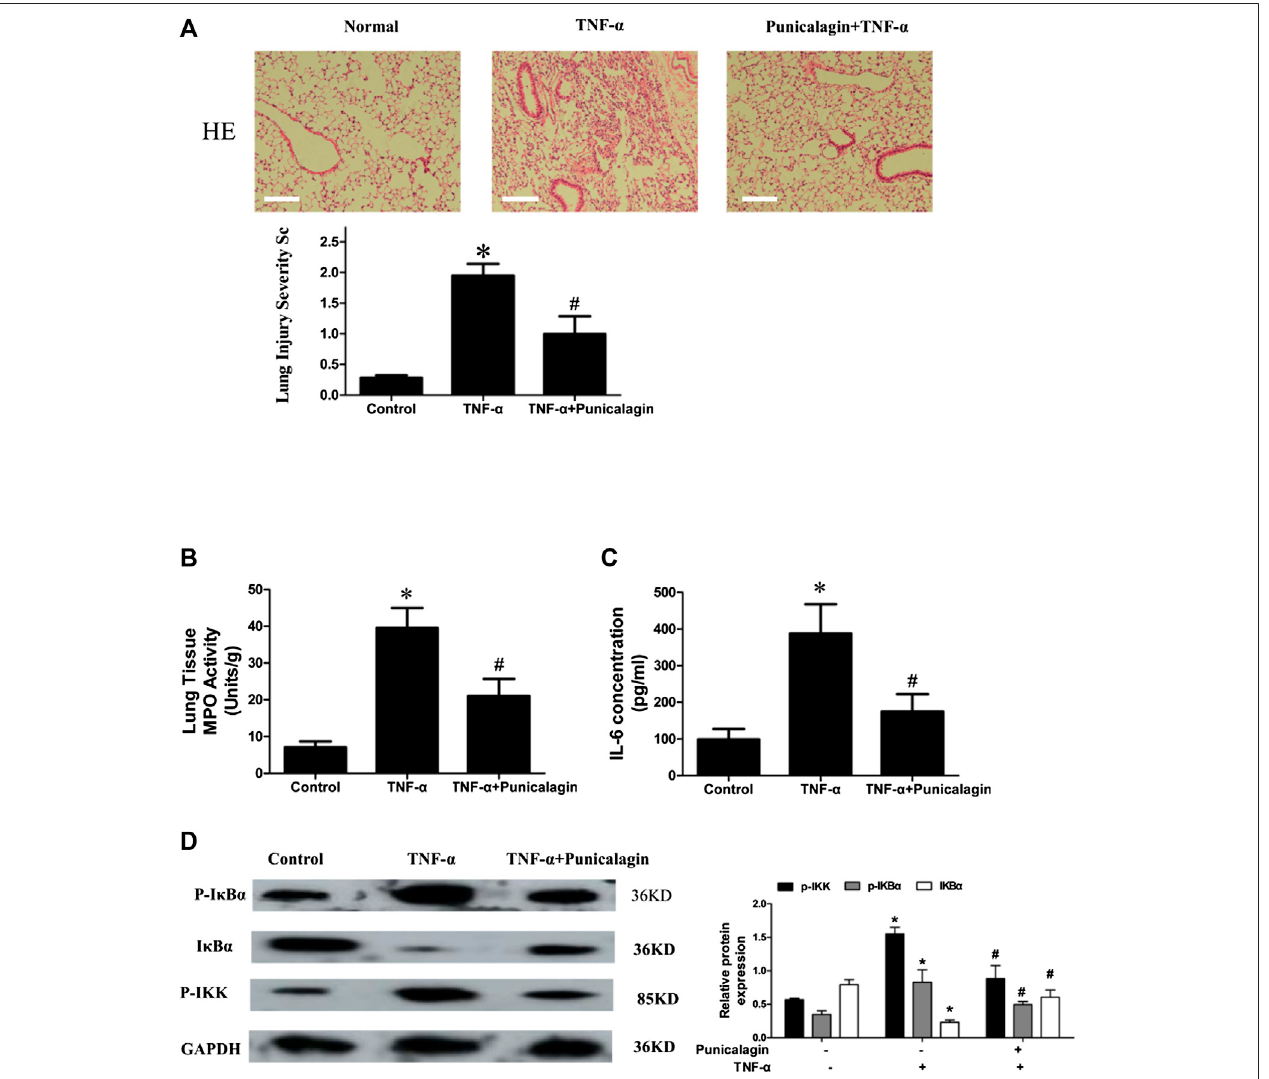
FIGURE11| Invivo modelandinhibitoryeffectofpunicalaginonneutrophilin fi ltration. (A) H&Estainingtoassessleukocyteaccumulationinthelungandtoquantify the severity of injury. Magni fi cation: 200 × (B, C) MPO activity measured by erythroperoxidase assay kit and IL-6 secretion detected with ELISA. Punicalagin inhibited TNF- α -induced activation of NF- κ B with western blotting (D) . Data are represented as mean ± SD. * p < 0.05, punicalagin treatment vs control group. # p < 0.05 TNF- α +punicalagin treatment vs. treatment with TNF- α alone.